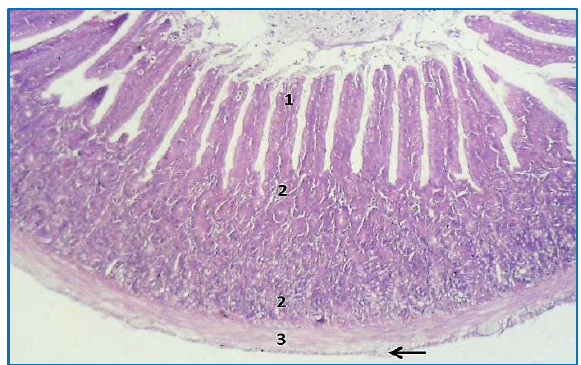
Figure, 8: section of jejunum (white eared bulbul) shows: Villus (1), lamina propria (2), tunica muscularis (3), tunica serosa (Arrow). H and E stain, 100X.